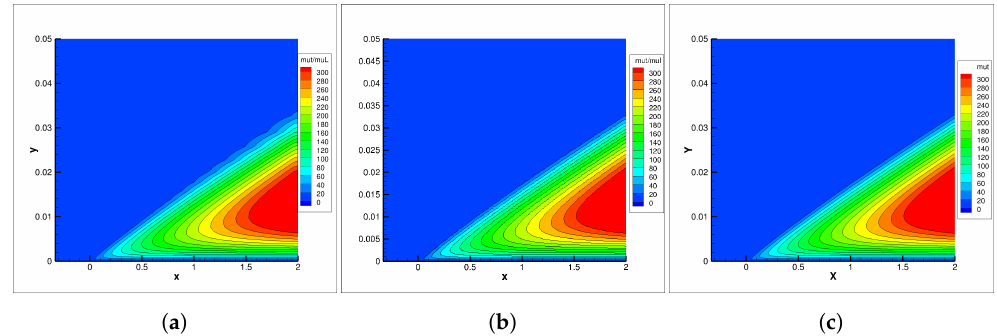
Figure 3. Contours of µ T / µ ∞ for flat plate using Spalart–Allmaras turbulence model: ( a ) UNS3D-SEQ, ( b ) UNS3D-PAR, and ( c ) FUN3D [20].